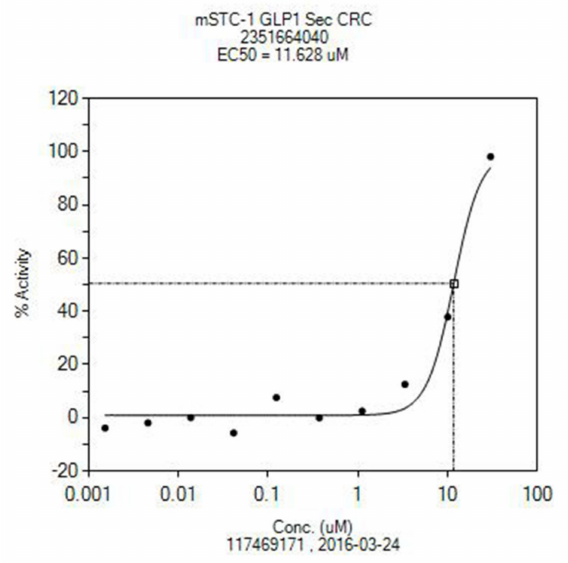
Figure 1. Increase in GLP-1 secretion by compound 43